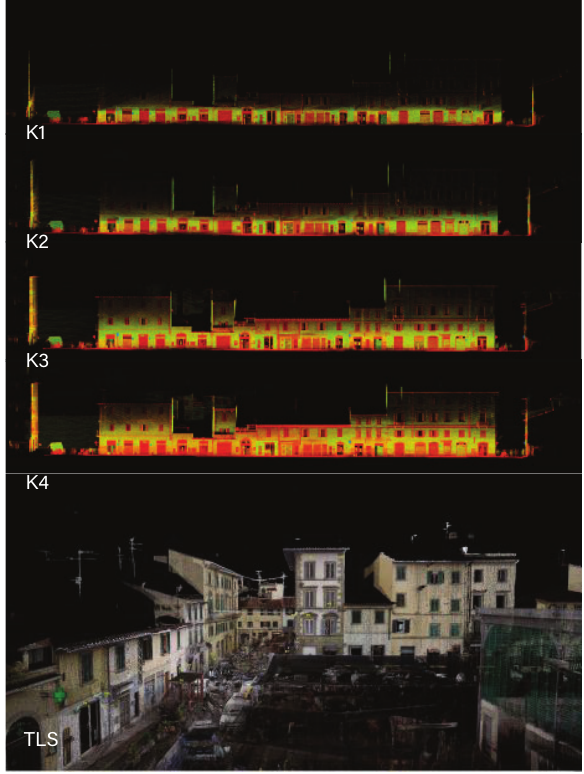
Figure 4. The operations of acquiring the street front with the mobile laser scanner were designed to be able to carry out a comparative analysis of different types of output resulting from methodically increasing the trajectory paths and shooting